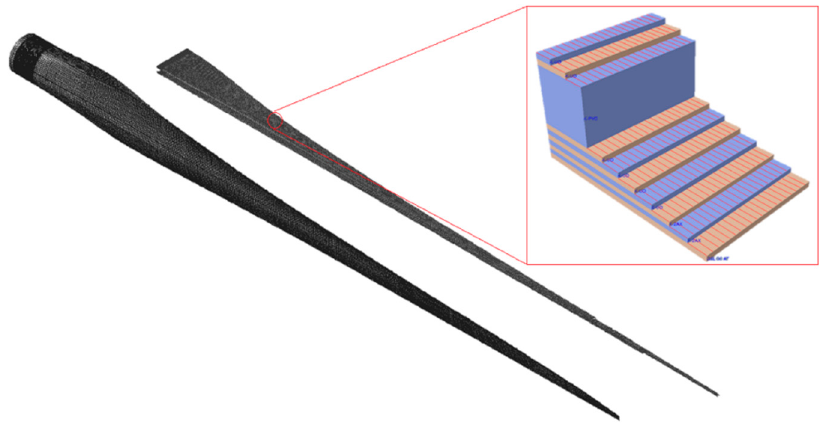
Figure 3. Overview of the structural mesh in the outer shells and in the shear webs of each blade, with a detailed view of the composite layup in one of the 64,000 shell elements.